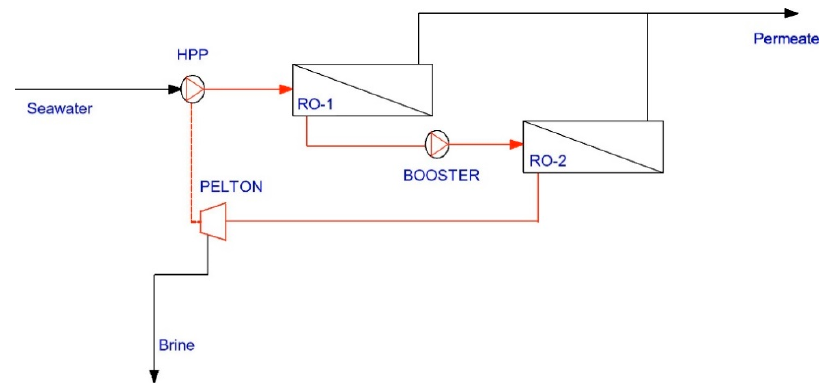
Figure 15. Schematic of a line with a Pelton turbine [64].